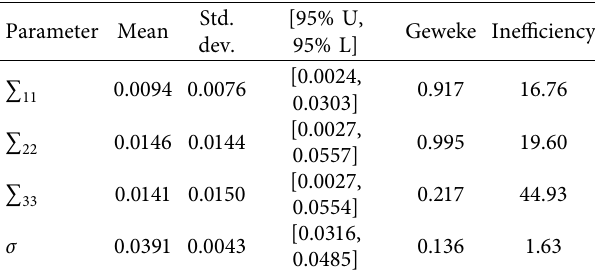
Table 6: Nonlinearity check based on BDS and RESET methods. Test